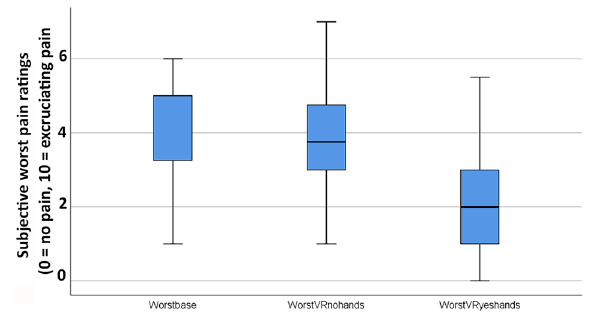
Figure 5. Phase 1. Compared to a passive VR version of the same world, interactive avatar VR was significantly more effective at reducing pain intensity (worst pain ratings).